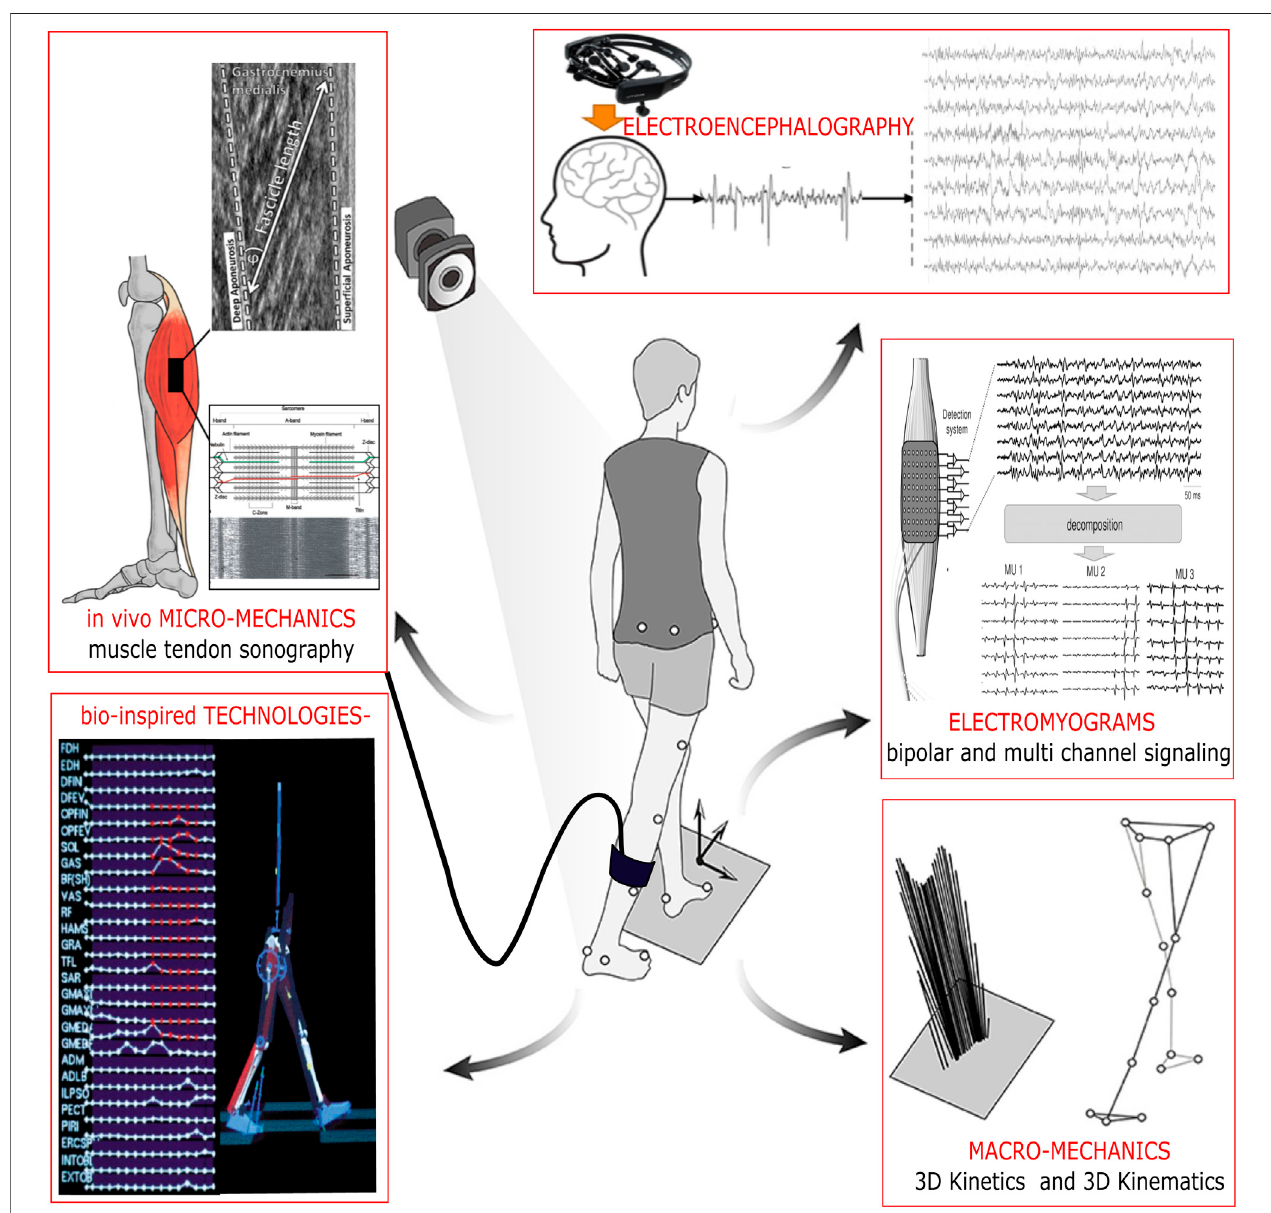
FIGURE 1 | The neural control of human movement is characterized by the resulting micro- and micromechanics. Scienti fi c evidence from holistic experiments is aiding in the development of new therapeutic approaches and bio-inspired technologies to improve motor control in healthy individuals and patients and trigger long- term